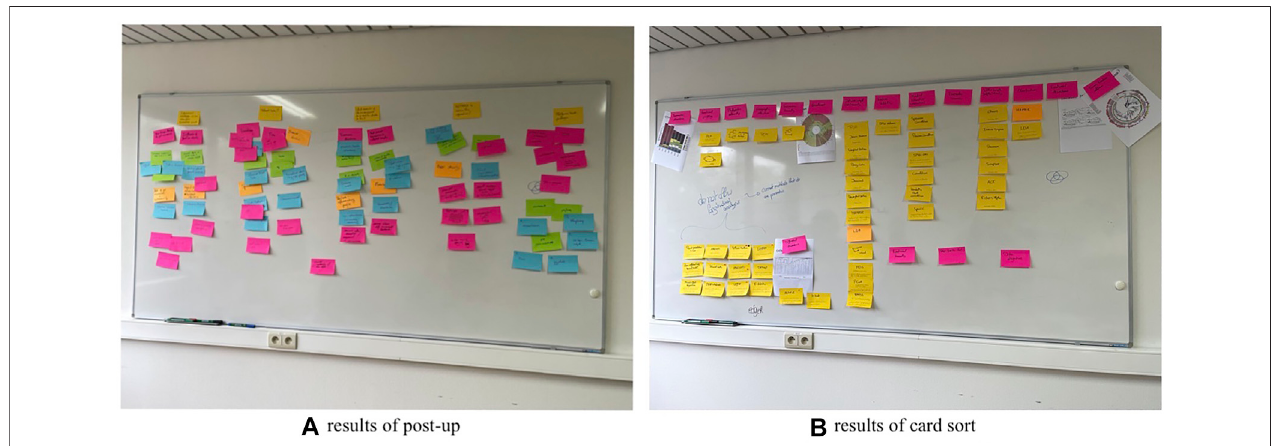
FIGURE 1 | Phase two and three of the workshops; (A) a post up brainstorm sessions in which participants were asked to provide their knowledge on 5 microbiomeanalysisrelatedquestions,and (B) aclosedcardsortingtoprovidetheirexpertsopiniononcurrentlyusedmethods.Theactualresultsofthepostupsession can be found in supplementary material ( Supplementary Tables S1, S5